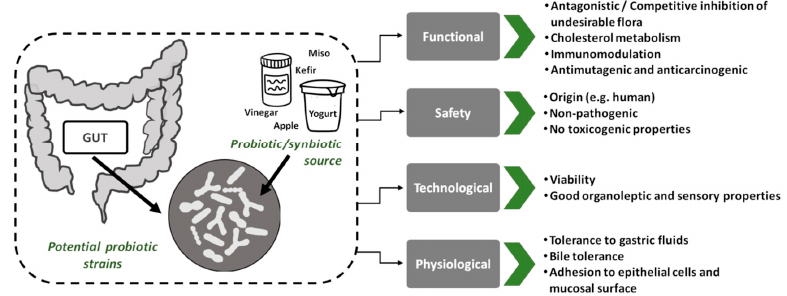
Figure 1. Criteria for the selection of probiotic strains.